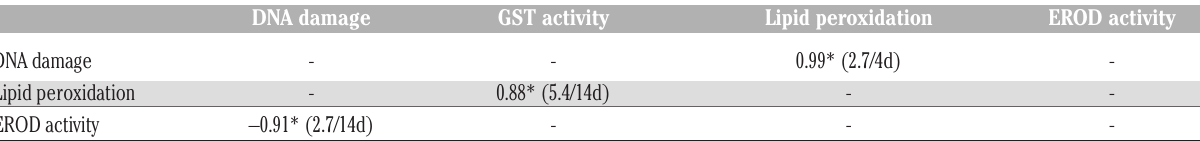
Table 4. Biomarkers correlation in rainbow trout exposed for 4 and 14 days to Mercier groundwater at 1.2, 2.7 and 5.4 km.